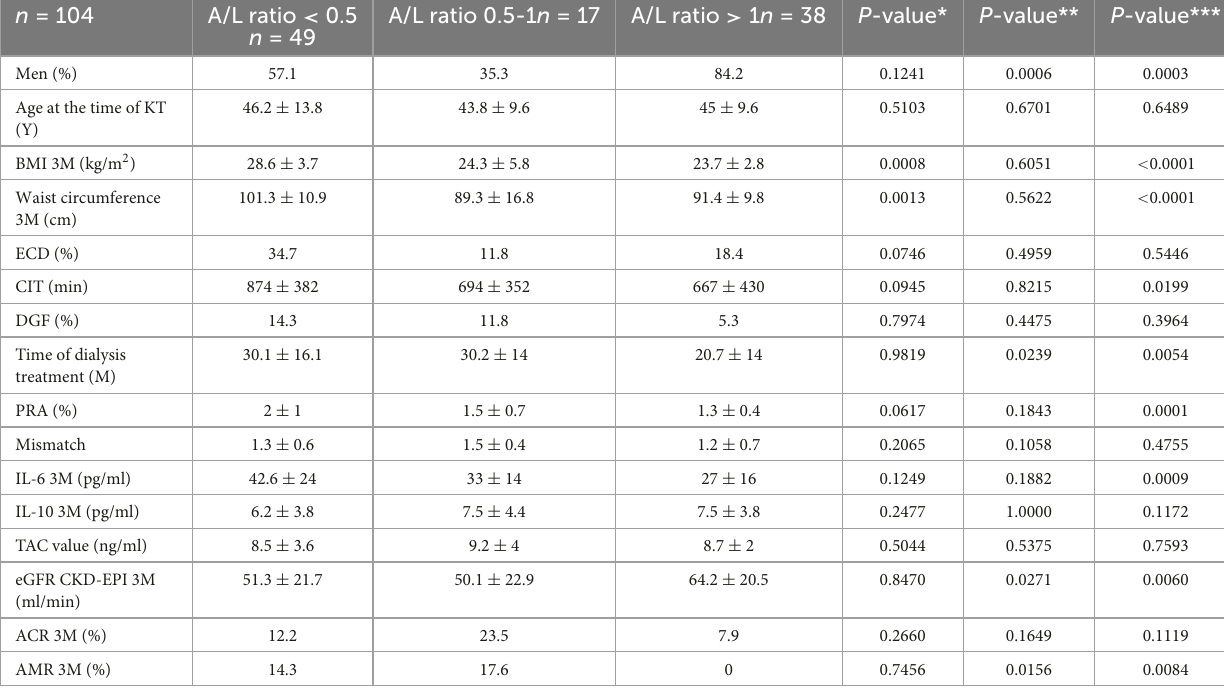
TABLE 3 Comparison of the observed groups based on A/L ratio at 3 months after kidney